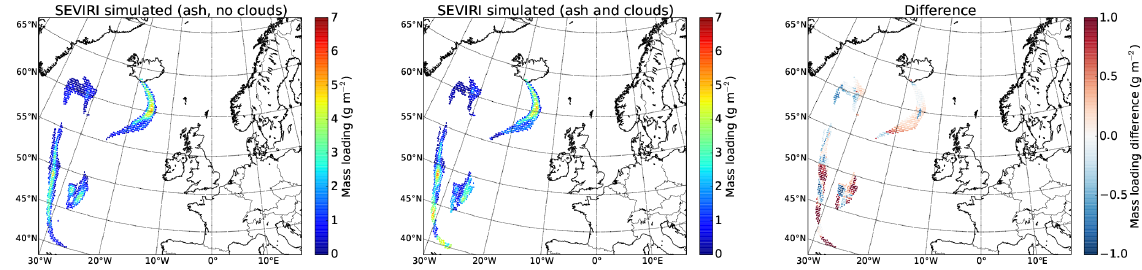
Figure 6. Same as Fig. 5, but data for 18:00UTC, 8 May,